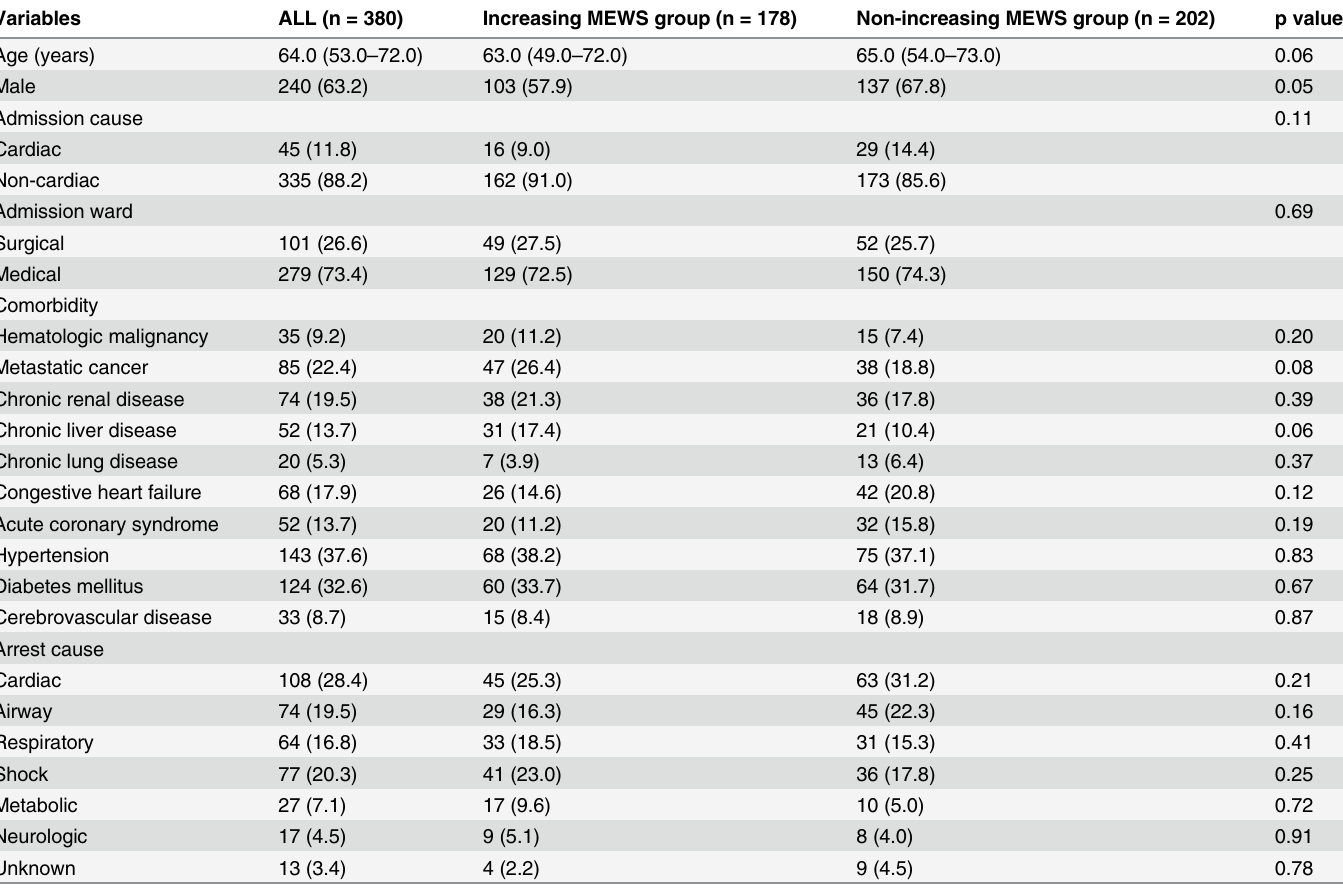
Table 2. Baseline Characteristics of the Study